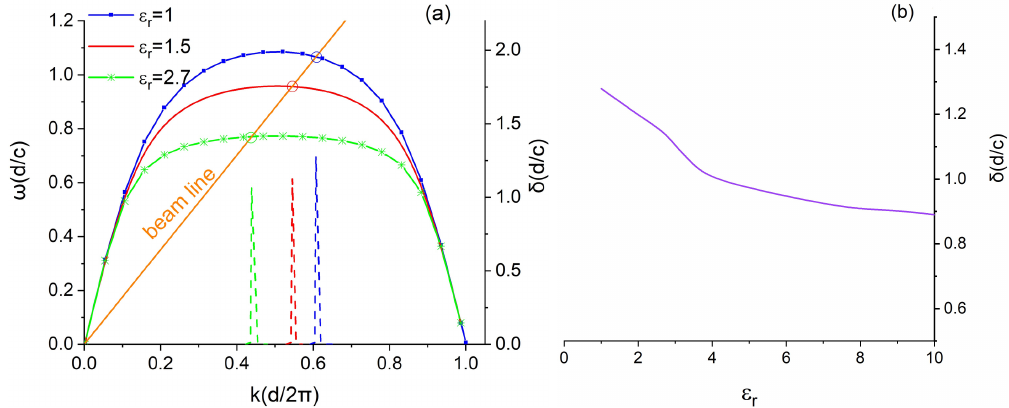
Figure 2: (a) Comparison of dispersion relations for different ε r s (solid curves). The beam line with voltage 20 kev is also plotted for reference. The growth rate ( δ ) for each curve, near the intersection (the circles), is indicated by a dash line. (b) The effect of relative dielectric ε r on the growth